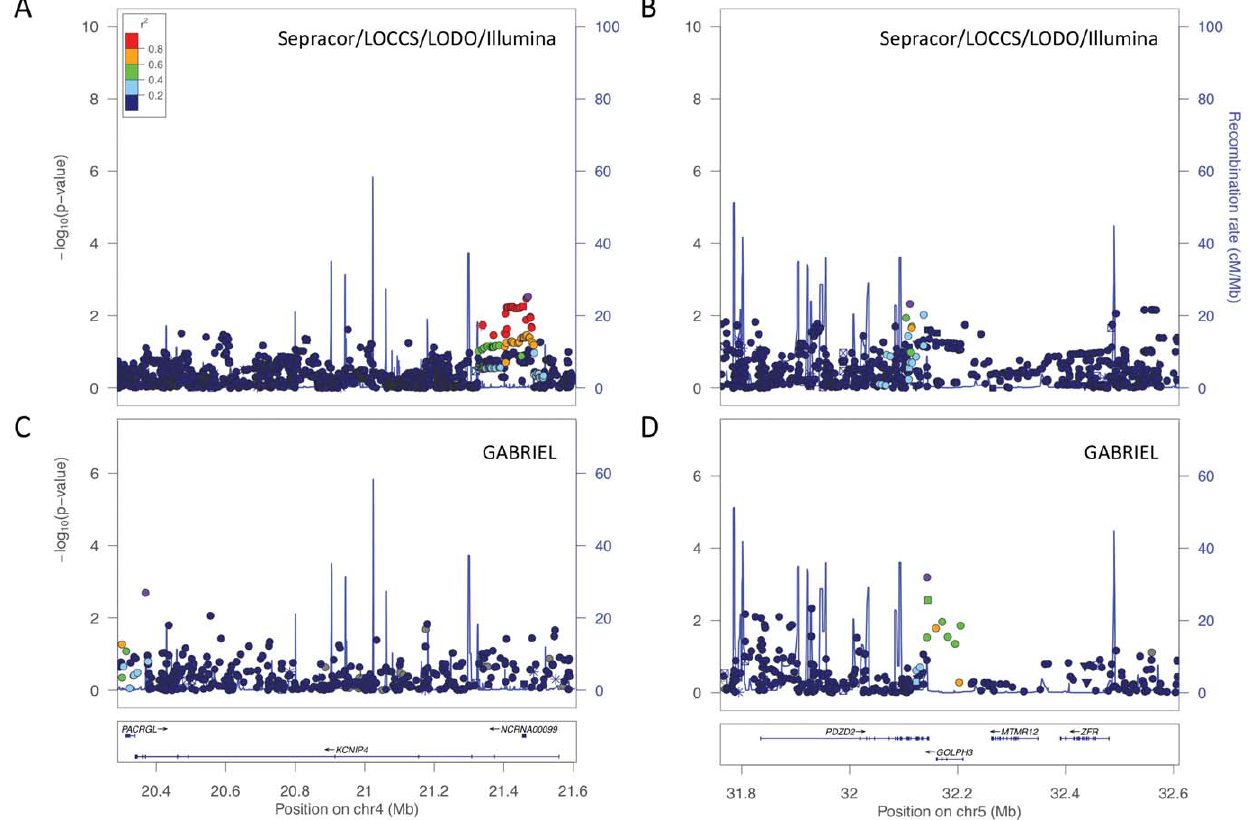
Figure 6. Top regions of association in two independent human asthma GWAS. KCNIP4 association in A) Sepracor/LOCCS/LODO/Illumina and C) GABRIEL. PDZD2/GOLPH3/MTMR12/ZFR association in B) Sepracor/LOCCS/LODO/Illumina and D) GABRIEL. The x-axis denotes position along corresponding human chromosome, while the y-axis denotes –Log 10 (P). LD between the SNPs with the lowest P-value to other SNPs in the plots are denoted in colors and were computed according to HapMap Phase 2 CEU data using LocusZoom [55].